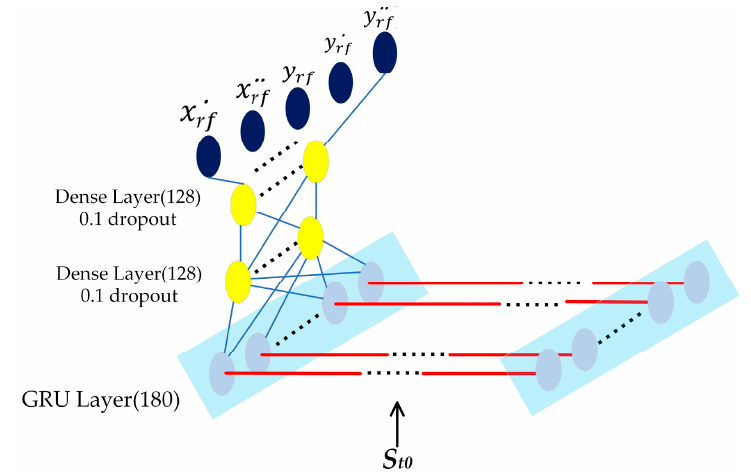
Figure 5. The Neural Network architecture.